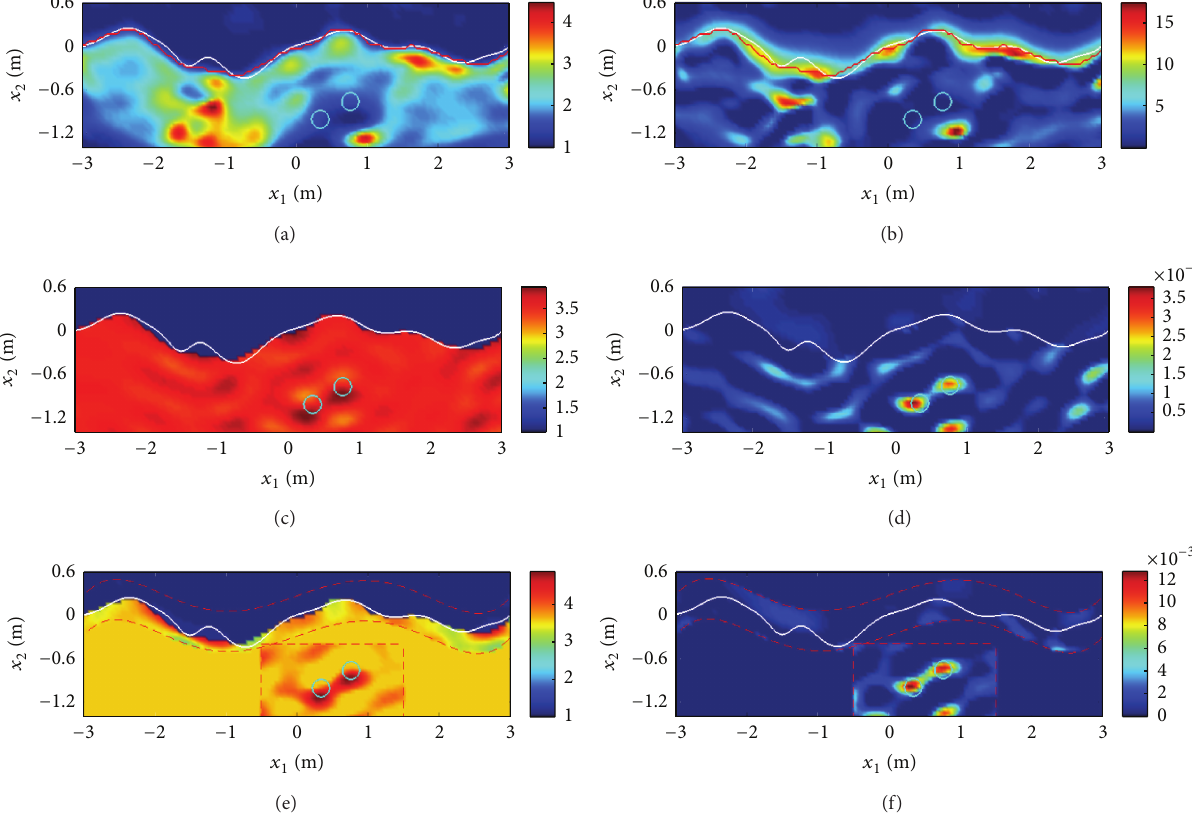
the dashed lines in Figures 5(e) and 5(f). These